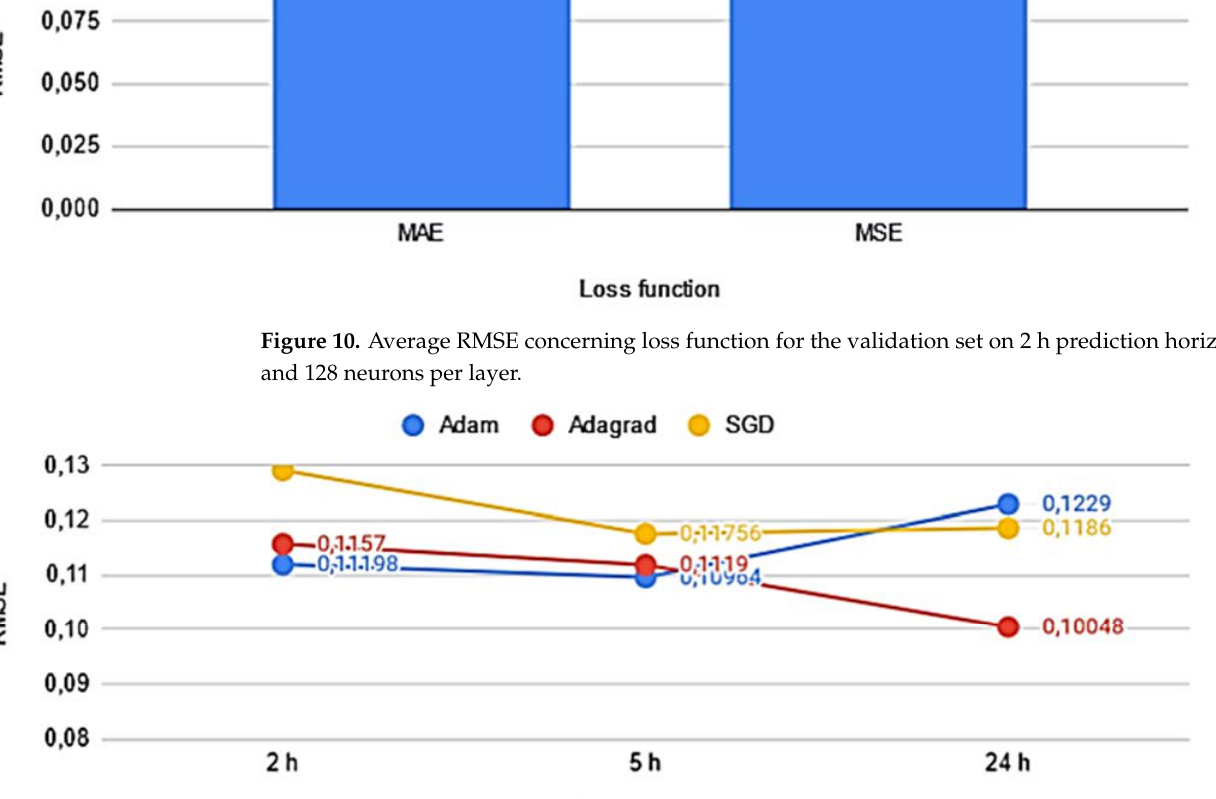
Figure 11. Average RMSE trend for bidirectional structure horizon prediction by the optimiser for the validation set. the validation set.